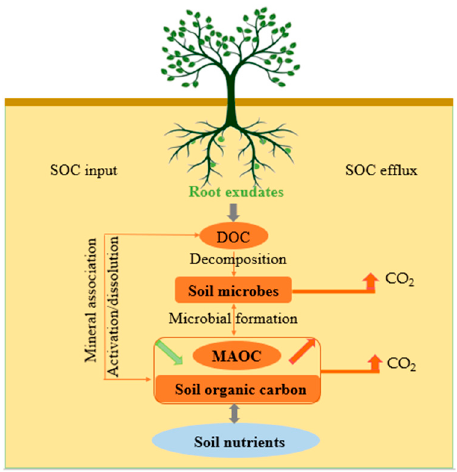
Figure 1. Main processes of soil organic carbon input and efflux mediated by root